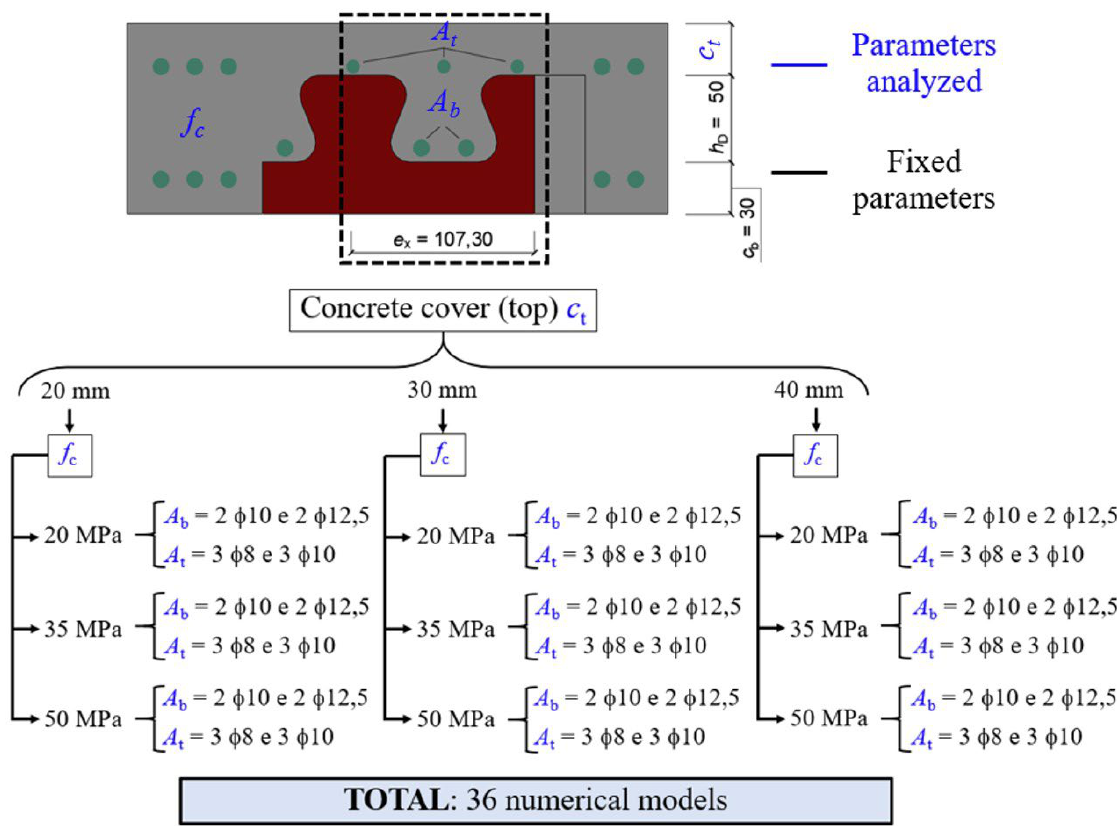
Figure 20. Parametric study (dimensions in mm).